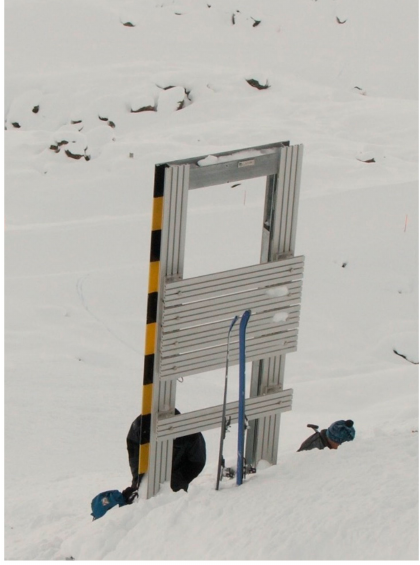
Figure 4. The obstacle after the 7 December 2010 avalanche (photo L.